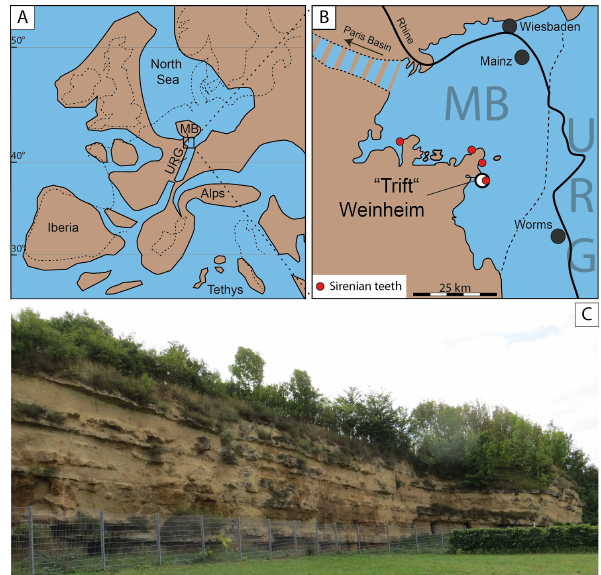
Figure 1. Map showing the paleogeography during the Rupelian stage and the sample locality in the Mainz Basin. (a) Position of the Mainz Basin (MB) in central Europe. URG stands for Upper Rhine Graben. Emerged land areas are shown in brown and marine environments in blue. Modified from Spiegel et al. (2007). (b) Sam- ple locality of the shells (Trift outcrop near Weinheim; white dot) and sea cow teeth (red dots). The presence of a western gateway (dashed area) connecting the Mainz Basin to the Paris Basin is un- clear. Dashed line denotes the tectonic boundary between the MB and URG. Modified after Grimm et al. (2011). (c) Photograph of the Trift outcrop near Weinheim, the type locality of the Alzey for- mation from which the bivalves were